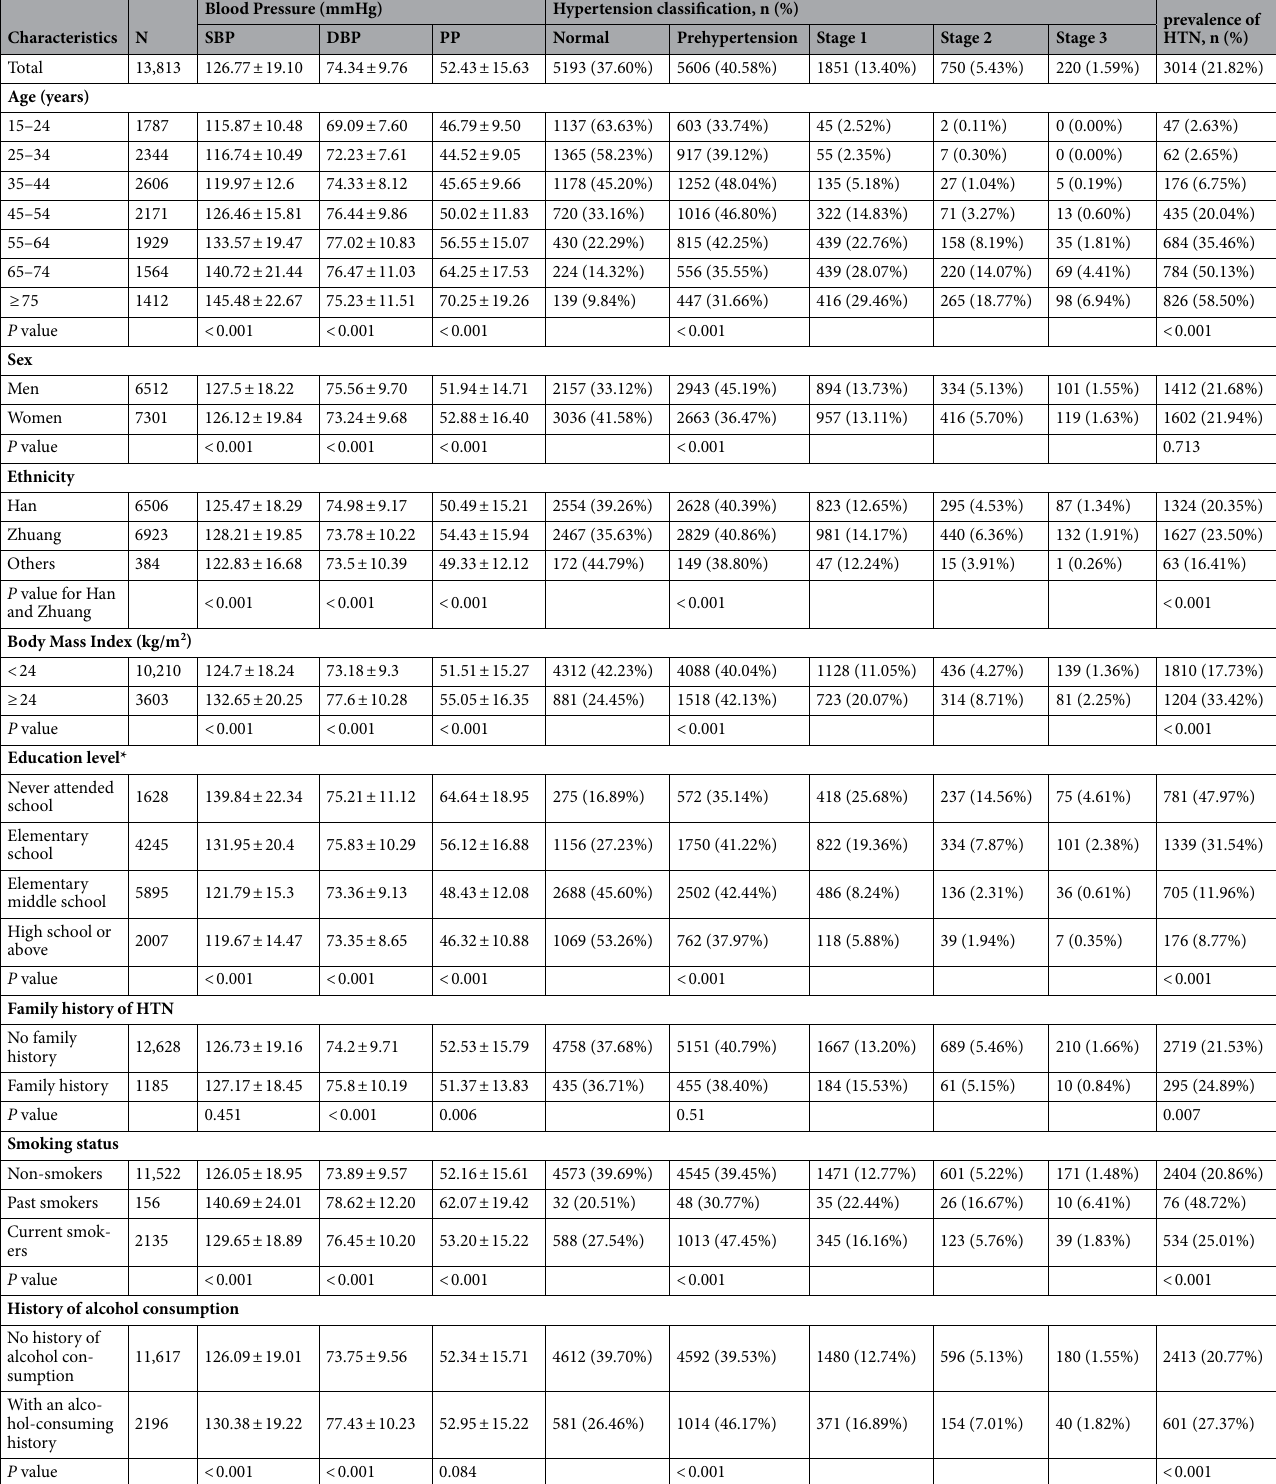
Table 2. Blood pressure and prevalence of HTN by characteristics. HTN hypertension, BMI Body Mass Index, SBP Systolic Blood Press, DBP Diastolic Blood Pressure, PP Pulse Pressure. Data are presented as n (%) or mean ± SD. *Missing 38